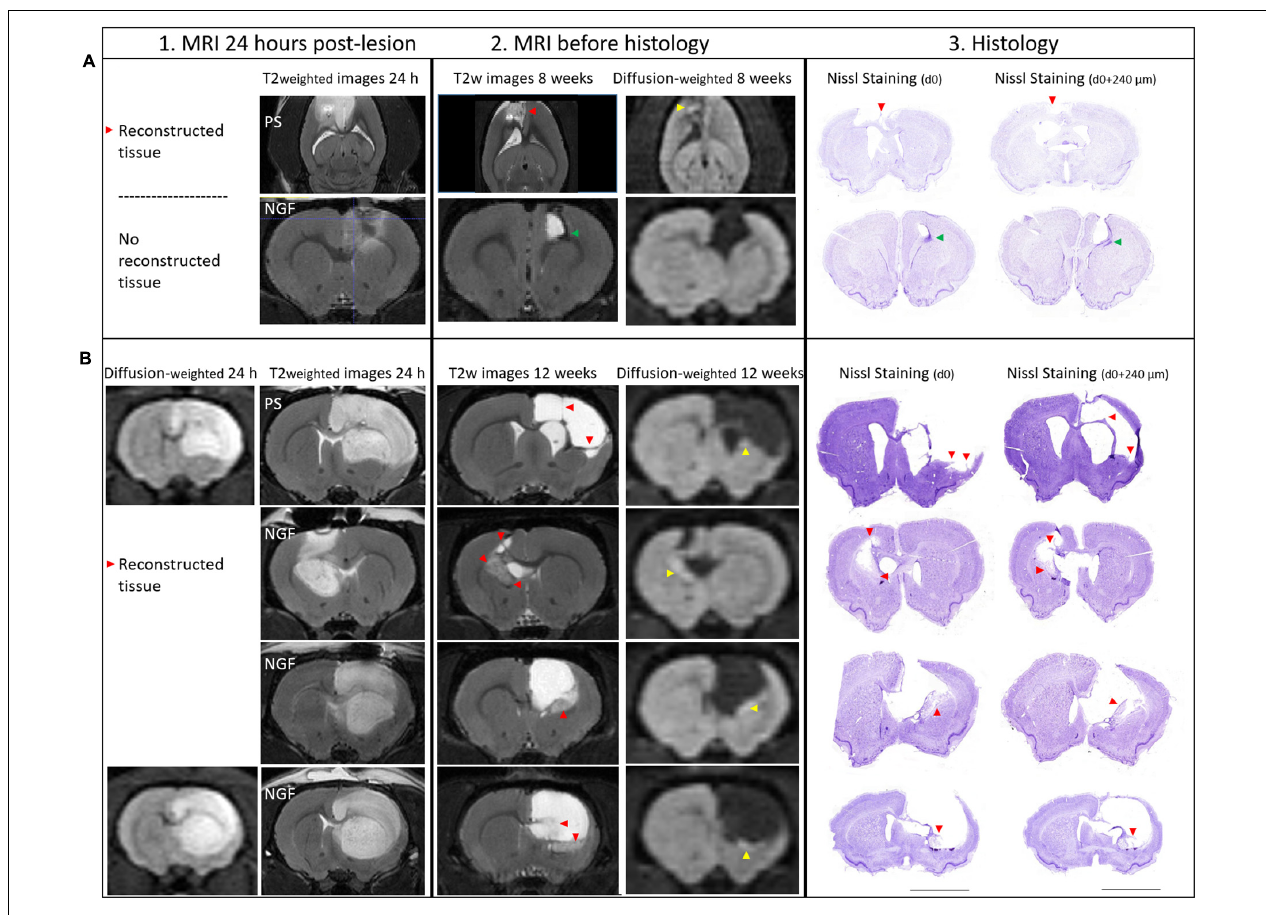
FIGURE 5 | MRI at 24 h (vertical section 1), 8 and 12 weeks (section 2) and Histology of brain sections (section 3) and characterization of the lesion: the reconstructed tissue at 8 and 12 weeks post-injury. 1. At 24 h post-lesion, T2 weighted and diffusion weighted images show hyperintense edematous regions, vasogenic and cytotoxic edema, respectively. Diffusion images were not acquired for all rats at 24 h. Lesions are characterized by an increase in T2 signal and an decrease in water diffusion (hyperintense area on diffusion-weighted images). 2. As tissue becomes necrotic, T2 and water diffusion increase. The reconstructed tissue was observed both on MRI slices and at the exact same location on histology sections (red arrowheads). Restricted water diffusion is evidenced by hyperintensities in the core of the reconstructed tissue (yellow arrowheads). 3. Nissl staining on two coronal sections separated by 240 µ m and the corresponding MRI slice (section 2, thickness 300 µ m ) showing the reconstructed tissue. (A) Brain images from two rats sacrificed at 8 weeks are shown: PS rat (upper panel) and NGF rat (lower panel). Axial images are shown for the PS rat because a MRI artifact, probably coming from a blood clot, caused a distortion in the coronal slices near the skull. Reconstructed tissue is detectable in PS rat, while it is not in NGF rat, because the ventricle is dilated and reaches the skull. In the perilesional area of NGF rat, a hypointense area on T2 images appears (green arrowhead), compatible with newly generated cells (DCX+ and BrdU+ cells, data not shown). (B) Brain images from four different rats that were sacrificed at 12 weeks post-injury are shown. The upper panel shows PS group, while the lower three panels the NGF group. For the PS rat, thin filaments of reconstructed tissue could be detected by MRI (red arrowheads). Diffusion weighted images corresponding to the same section are shown on the right. Histological assay may damage the fragile neotissue (Nissl staining). Scale bars: 5 mm. MRI: magnetic resonance imaging; PS: physiological saline; NGF: Nerve Growth Factor; DCX: doublecortin and BrdU: BrdU: 5 (cid:48)